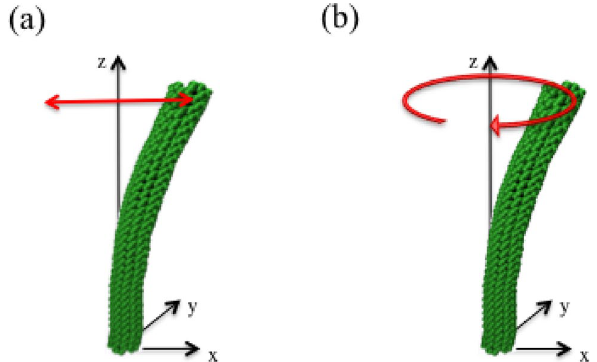
Figure 1. Visualization of motion from MD simulation. The average coordinate of each carbon ring perpendicular to tube axis is amplified by a factor of 5 to clearly visualize the motion: ( a ) planar bending motion, ( b ) nonplanar